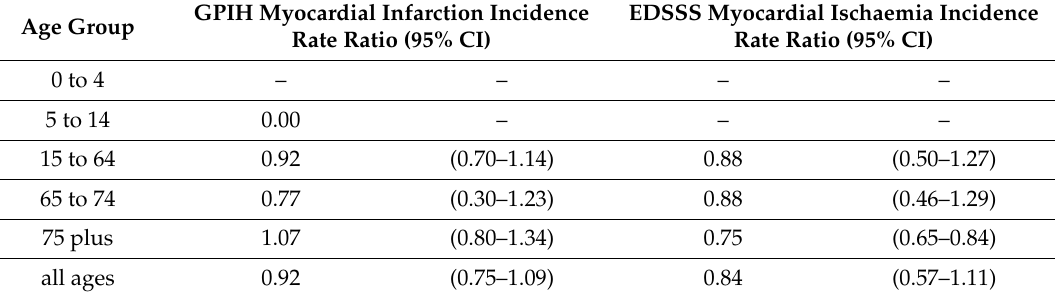
Figure 1. Daily GPIH consultations for myocardial infarction (65–74 years). Table 2. Incidence Rate Ratios (IRRs) comparing mean incidence of GPIH myocardial infarction (mean weekly rate) and EDSSS myocardial ischaemia (mean weekly % attendances) for weeks 28–30 of 2013 compared to the same period in 2012 and